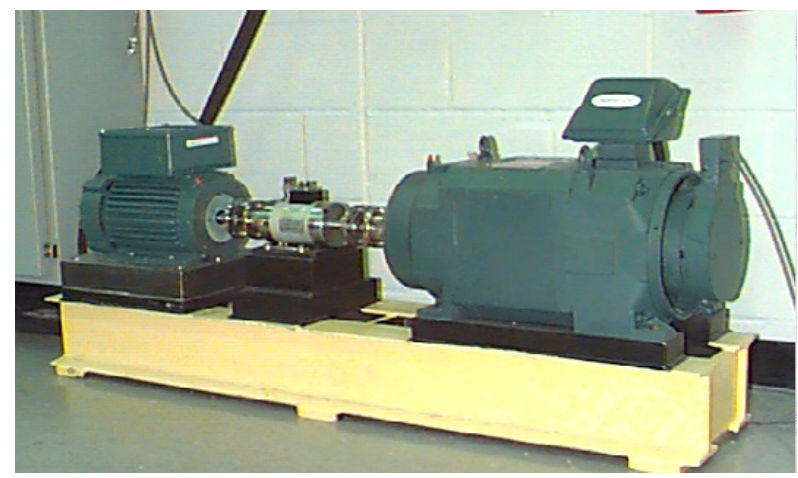
Figure 6. Test-rig of the rolling bearing [37].